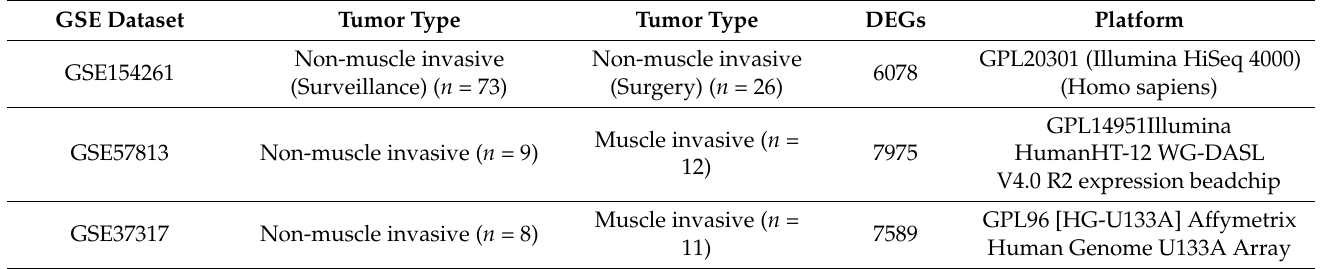
Table 1. Information on GEO datasets and